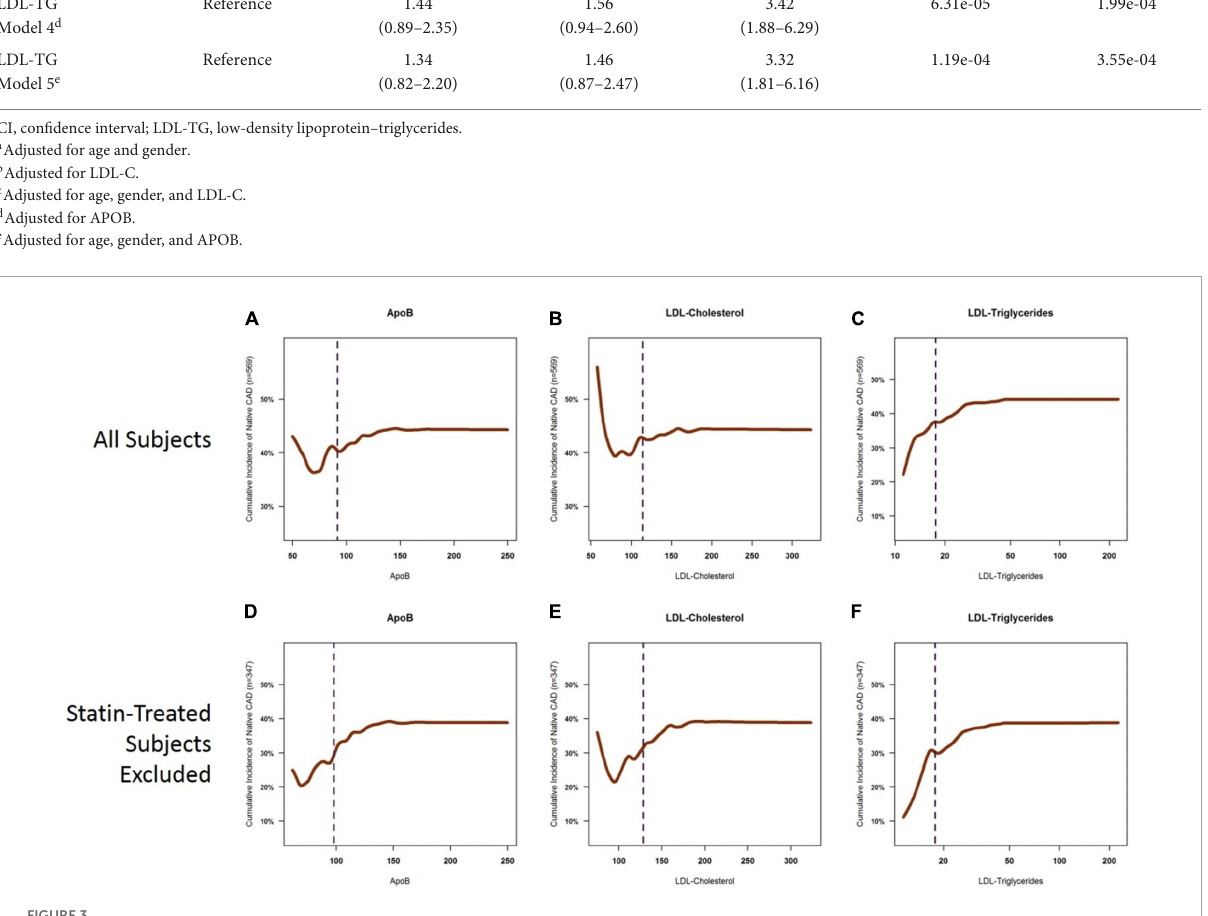
FIGURE3 Cumulative incidence curves for the presence of coronary atherosclerosis as a function of ApoB, LDL-C, and LDL-TG. Cumulative incidence curves demonstrate the well-described relationship between ApoB and LDL-C levels and the incidence of atherosclerosis, which is primarily apparent in the ApoB range of 50–150 mg/dl and in the LDL-C range of 60–200 mg/dl. The left tails of the curves are distorted by statin-treated patients (A,B) , in which you see a high cumulative incidence of atherosclerosis despite very low levels of ApoB (panel A) and LDL-C (B) . This likely represents patients with known ASCAD whose LDL-C and ApoB levels have been lowered by aggressive statin therapy. The sigmoid relationship for ApoB and LDL-C is more apparent when statin-treated patients are excluded (D,E) . On the other hand, a clear, near-exponential relationship is seen for the incidence of atherosclerosis as a function of serum LDL-TG levels, with no apparent effect of statin therapy (C,F) . ApoB, apolipoprotein B; LDL, low density